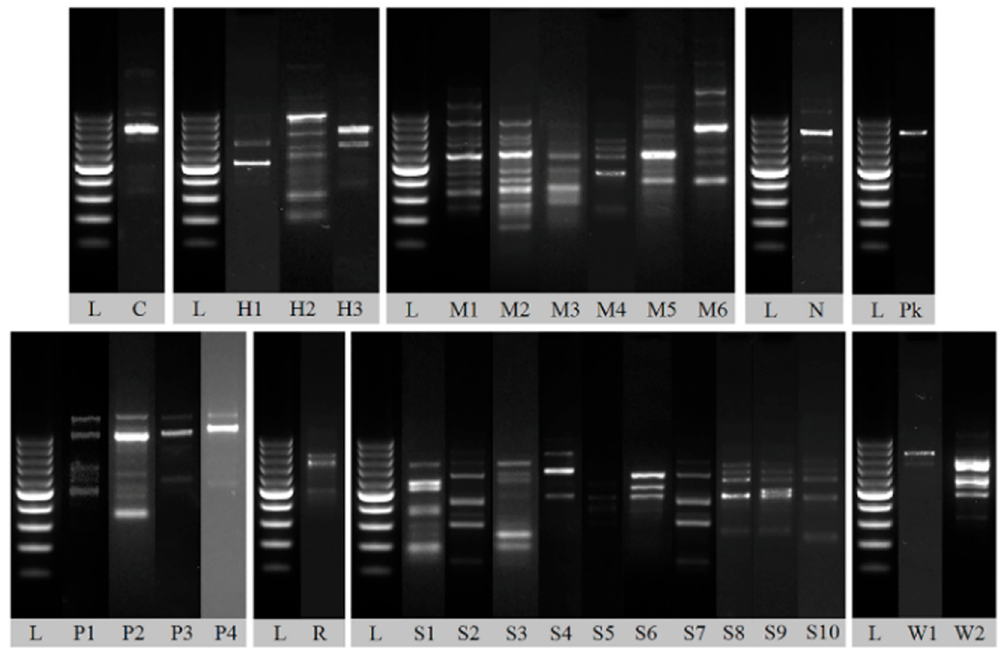
Figure 5. Representative random amplification of polymorphic DNA (RAPD) patterns obtained with